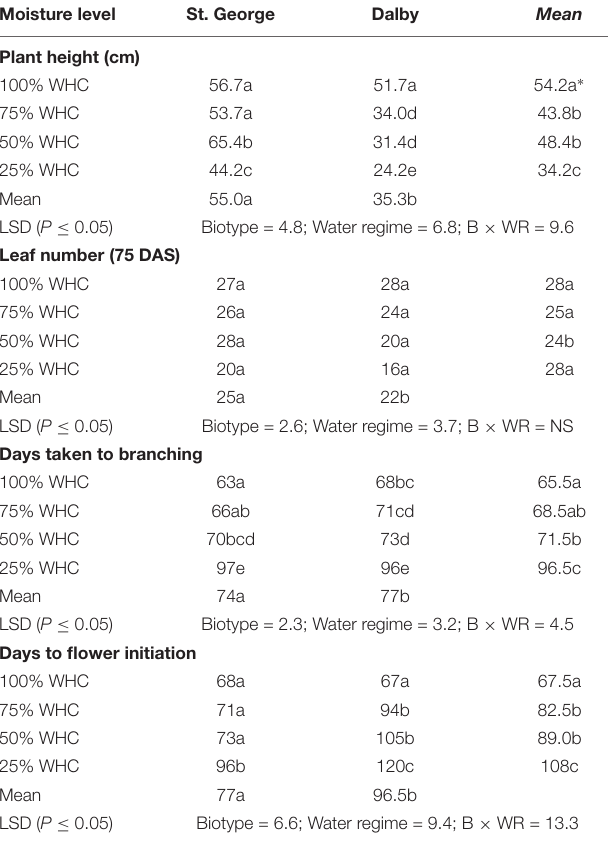
TABLE 1 | Effect of different soil moisture levels (factor 2) on final plant height, leaf number at 75 days after sowing and days taken to branching and flowering initiation of two Australian biotypes (St. George and Dalby; factor 1) of Sisymbrium thellungii